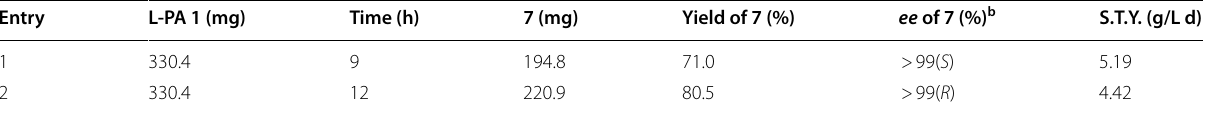
Table 2 Preparation of ( S )-7 and ( R )-7 from L-PA 1 with the combined resting cell of E. coli (RFP-DEA-CGS) and E. coli (MVTA) or E. coli (EB-DGA)